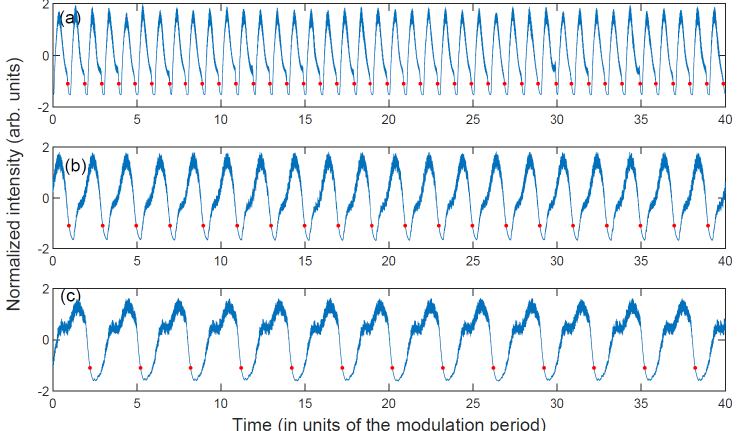
Figure 2. Time series of the laser intensity (normalized to zero − mean and unit variance) in different locking regions: ( a ) 1:1 locking for f mod = 5 MHz, a mod = 0.045; ( b ) 2:1 locking for f mod = 24 MHz, a mod = 0.0125; ( c ) 3:1 locking for f mod = 42 MHz, a mod = 0.0125 (these parameters were indicated in Figure 1 with a circle, a triangle, and a square, respectively). In all panels, the red dots mark the spike times (when the intensity decreases below the threshold −